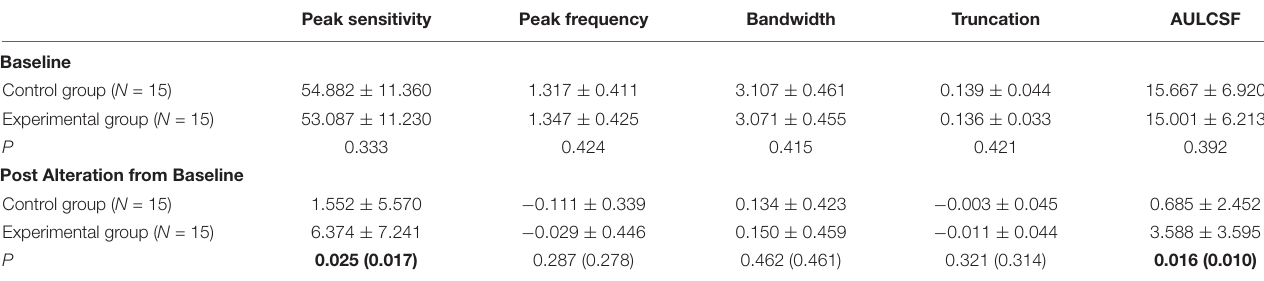
TABLE 1 | Summary of mean qCSF parameters at baseline, post alteration from baseline in two groups.